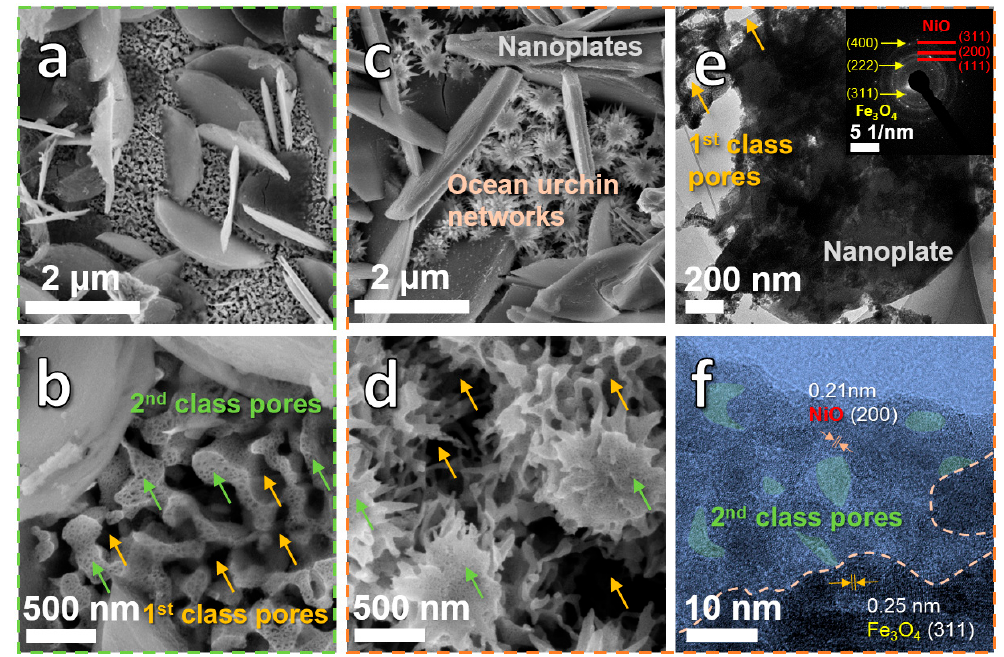
Figure 2. ( a , b ) SEM images of Ni 5 Fe 5 Al 90 ribbons after dealloying in 2 M NaOH solution for 5 h; SEM ( c , d ) and TEM ( e , f ) images of Ni 5 Fe 5 Al 90 ribbons after dealloying in 2 M NaOH solution for 24 h. The phase compositions of the as-synthesized samples were distinguished by XRD (Figure 3a).